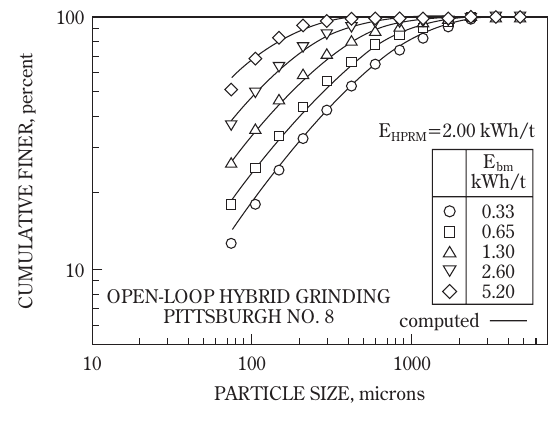
Fig. 10 Experimental and computed size distributions of Pitts- burgh No. 8 coal produced by open-circuit hybrid ball mill grinding of material that had first been ground at an energy expenditure of 2 kWh/t in the